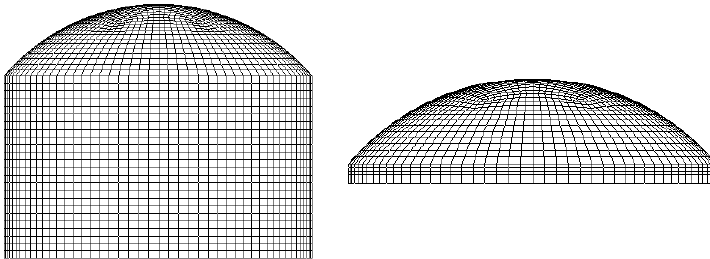
Figure 7. Computational mesh for the CFD combustion model.